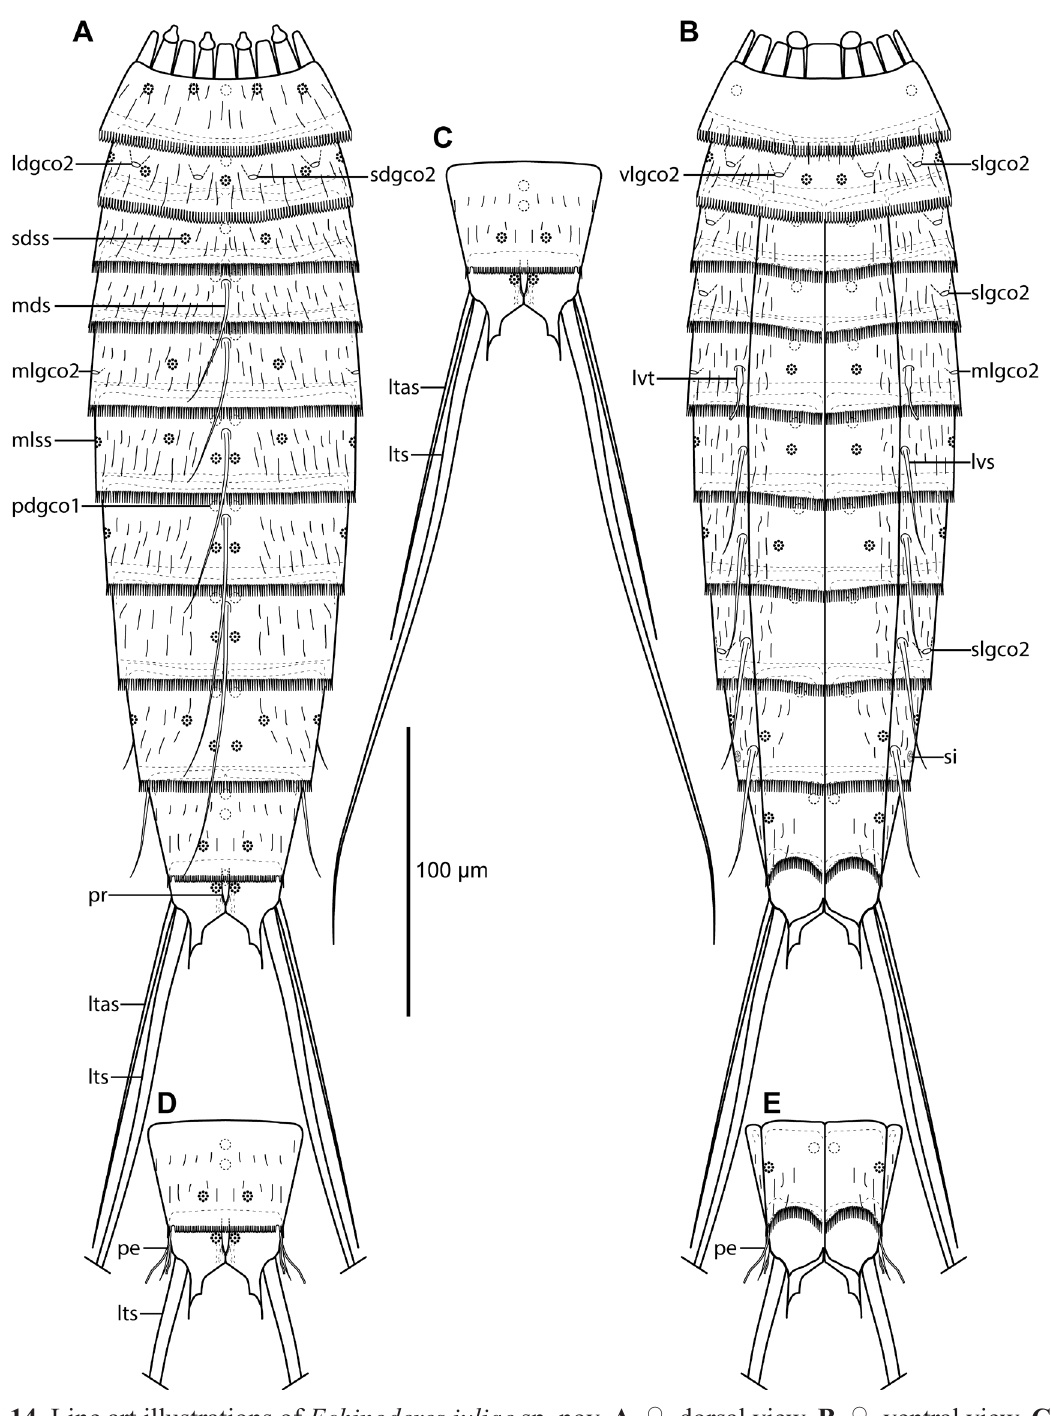
Fig. 14. Line art illustrations of Echinoderes juliae sp. nov. A . ♀, dorsal view. B . ♀, ventral view. C . ♀, segments 10 to 11, with lateral terminal spines drawn in full length, dorsal view. D . ♂, segments 10 to 11, dorsal view. E . ♂, segments 10 to 11, ventral view. Abbreviations: ldgco2 = laterodorsal glandular cell outlet type 2; ltas = lateral terminal accessory spine; lts = lateral terminal spine; lvs = lateroventral spine; lvt = lateroventral tube; mds = middorsal spine; mlgco2 = midlateral glandular cell outlet type 2; mlss = midlateral sensory spot; pdgco1 = paradorsal glandular cell outlet type 1; pe = penile spines; pr = protuberance; sdgco2 = subdorsal glandular cell outlet type 2; sdss = subdorsal sensory spot; si = sieve plate; slgco2 = sublateral glandular cell outlet type 2; vlgco2 = ventrolateral glandular cell outlet